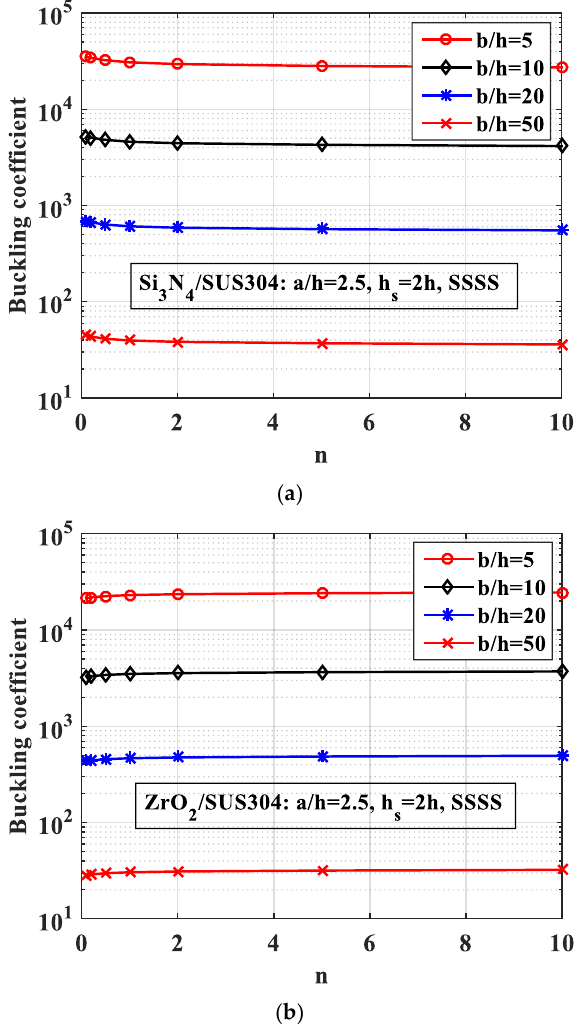
Figure 15. Variation of the buckling coefficient of the plate with two parallel stiffeners by the thickness of the structure. ( a ) Si 3 N 4 /SUS304; ( b ) ZrO 2 /SUS304.